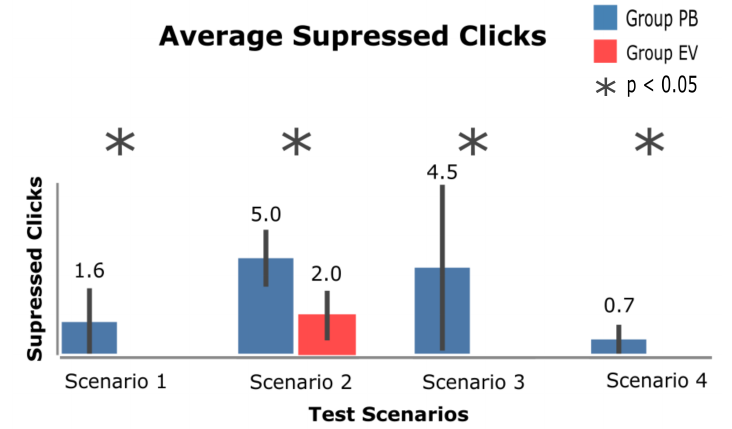
Figure 19. Average clicks suppressed across groups on each